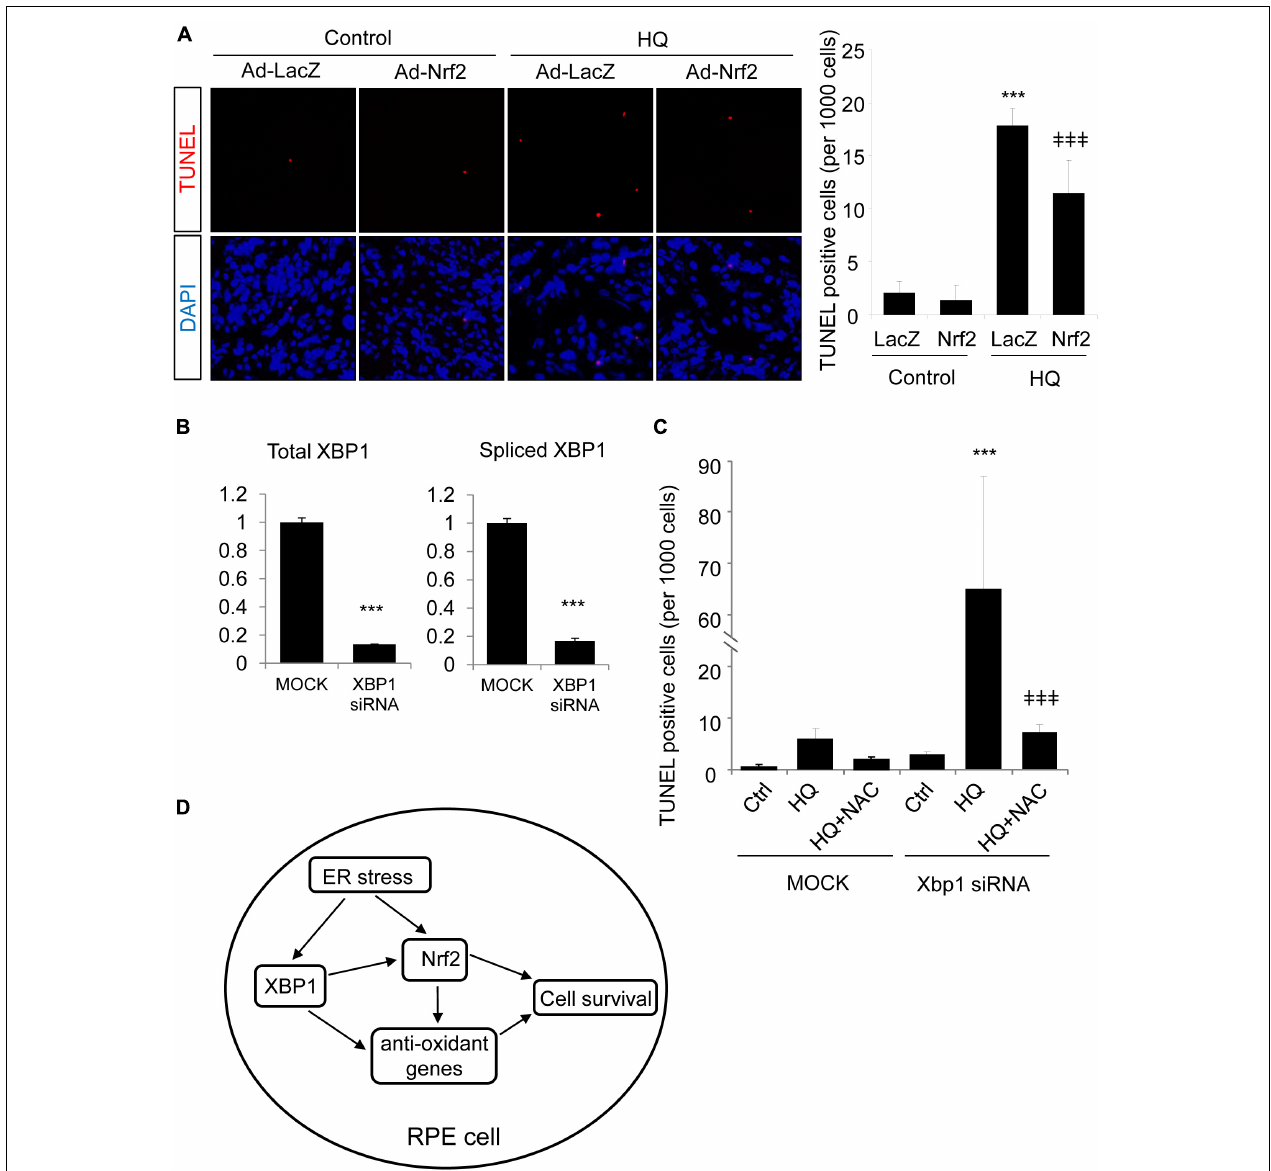
FIGURE 8 | Overexpression of Nrf2 protects ARPE-19 cells from hydroquinone induced injury. (A) ARPE-19 cells were transfected with adenovirus overexpressing Nrf2 or LacZ as control for 24 h, then treated with a potent pro-oxidant, hydroquinone (100 µ M, 24 h), for another 24 h. Cell DNA fragmentation was detected by TUNEL assay and quantified by cell counting (mean ± SD, n = 5 random 10 × microscope field, ∗∗∗ p < 0.001 vs. control, ‡‡‡ p < 0.001 vs. Ad- LacZ transfected cells with HQ treatment). (B) ARPE-19 cells were transfected with XBP1 siRNA or lipofectamine only (Mock) as control for 24 h, XBP1 knockdown efficiency was detected by real-time RT PCR ( ∗∗∗ p < 0.001). (C) ARPE-19 cells were transfected with XBP1 siRNA or lipofectamine only (Mock) as control for 24 h, then treated with hydroquinone (100 µ M, 24 h) with or without N-Acetylcysteine (NAC) pre-treatment (1 mM, 2 h). Cell DNA fragmentation was detected by TUNEL assay and quantified by cell counting (mean ± SD, n = 5 random 10 × microscope field, ∗∗∗ p < 0.001 vs. untreated XBP1 siRNA transfected cells, ‡‡‡ p < 0.001 vs. XBP1 siRNA transfected and HQ treated cells). (D) Schema of the regulation of Nrf2 by XBP1 in RPE cells. In the RPE, XBP1 upregulates the expression of Nrf2,